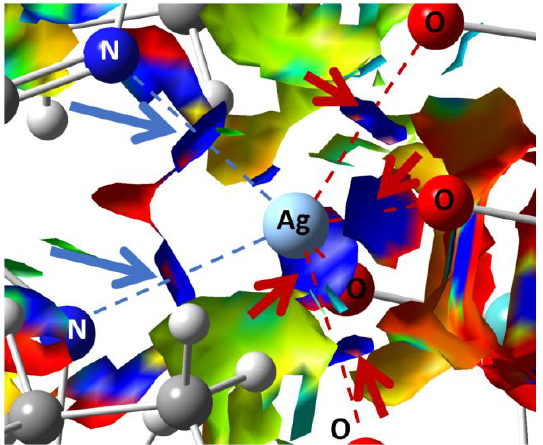
Figure 4. Plots of the isosurfaces of non-covalent interaction index mapped over the reduced density gradient ( s = 1/2). Legend of colors: − 0.012 a.u. (red; repulsion) to +0.012 a.u. (blue; attraction). Ag-O and Ag-N attractive NCIs are pointed out by red and blue arrows, respectively. The calculations were conducted on the optimized geometry.